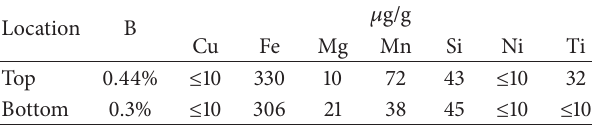
Table 1: Chemical composition of the Al-B sample.